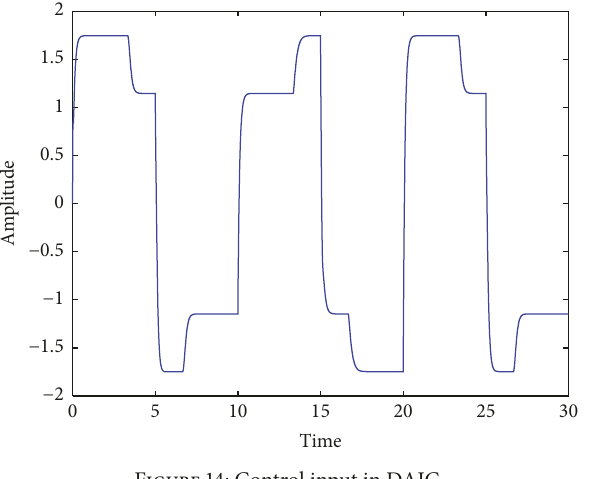
Figure 14: Control input in DAIC.